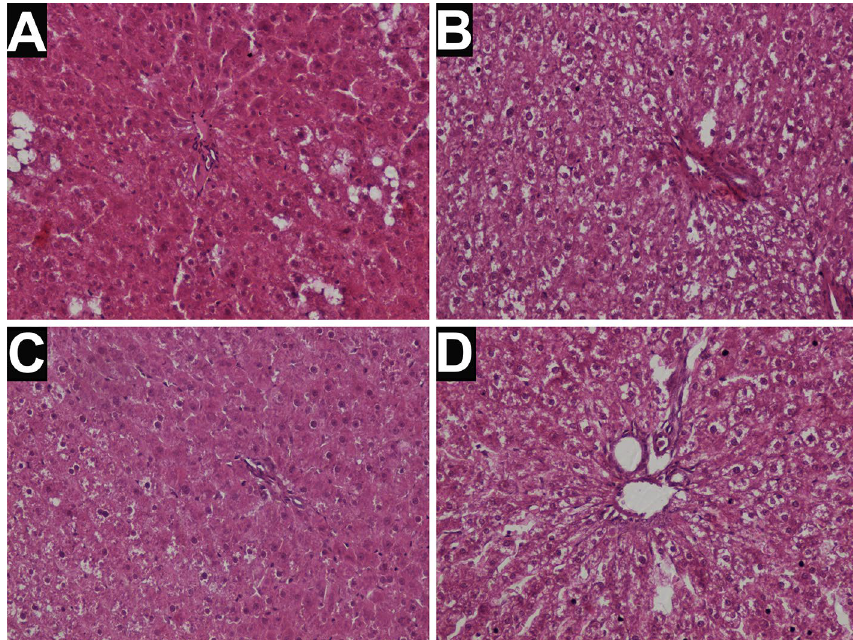
Figure 3. Histological image of liver of Zucker (Crl:ZUC(ORL)-Lepr fa ) rats after 12 weeks: ( A ) and ( B ) after control (SHAM) surgery; ( C ) and ( D ) after ileal transposition (IT) surgery. H&E staining, ×200.